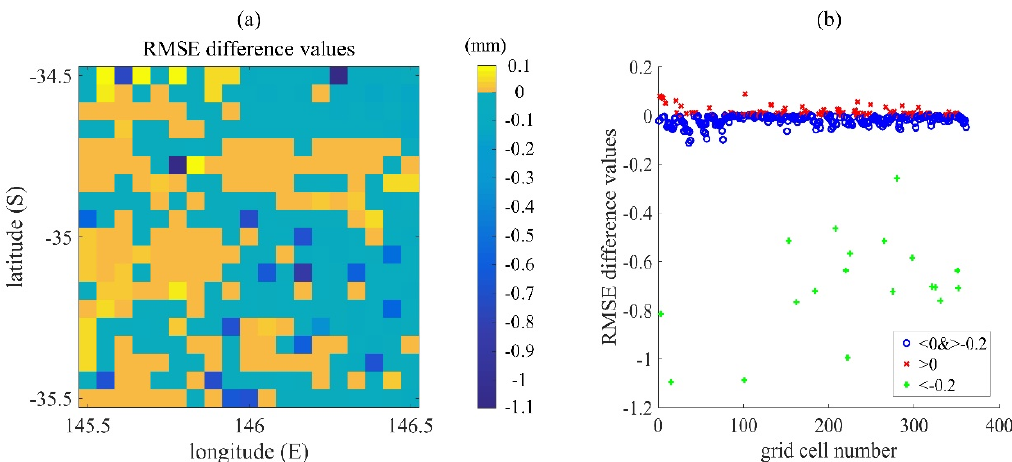
Figure 10. The deviation in RMSEs between the data assimilations using the BGM and the MC methods: ( a ) Spatial distribution of RMSE difference values over study area; ( b ) The values of RMSE difference values with grid cell number.